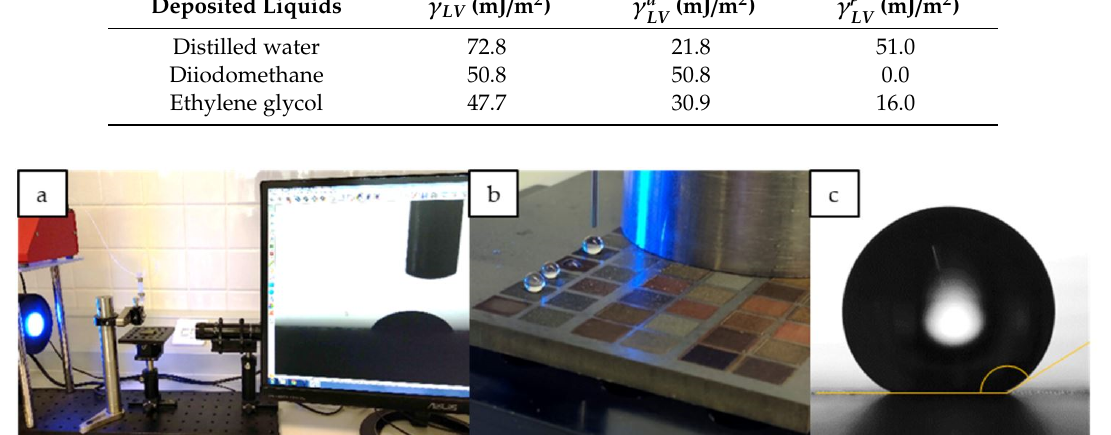
Table 4. Polar and dispersive components of the liquids used for the calculation of the free surface energy. Table4. Polaranddispersivecomponentsoftheliquidsusedforthecalculationofthefreesurfaceenergy. Deposited Liquids